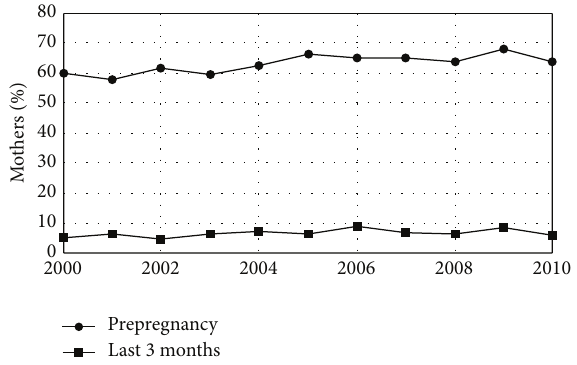
Figure 4: Maternal alcohol consumption by year. Fraction of mothers who drank alcohol in the last 3 months before pregnancy and the last 3 months of pregnancy for women giving birth in Maine by year. Healthy People 2020 has objectives of a 10% increase in the percent of women who did not drink alcohol prior to pregnancy as well as a 10% increase in abstinence from alcohol among pregnant women. Maine is not moving toward this goal.